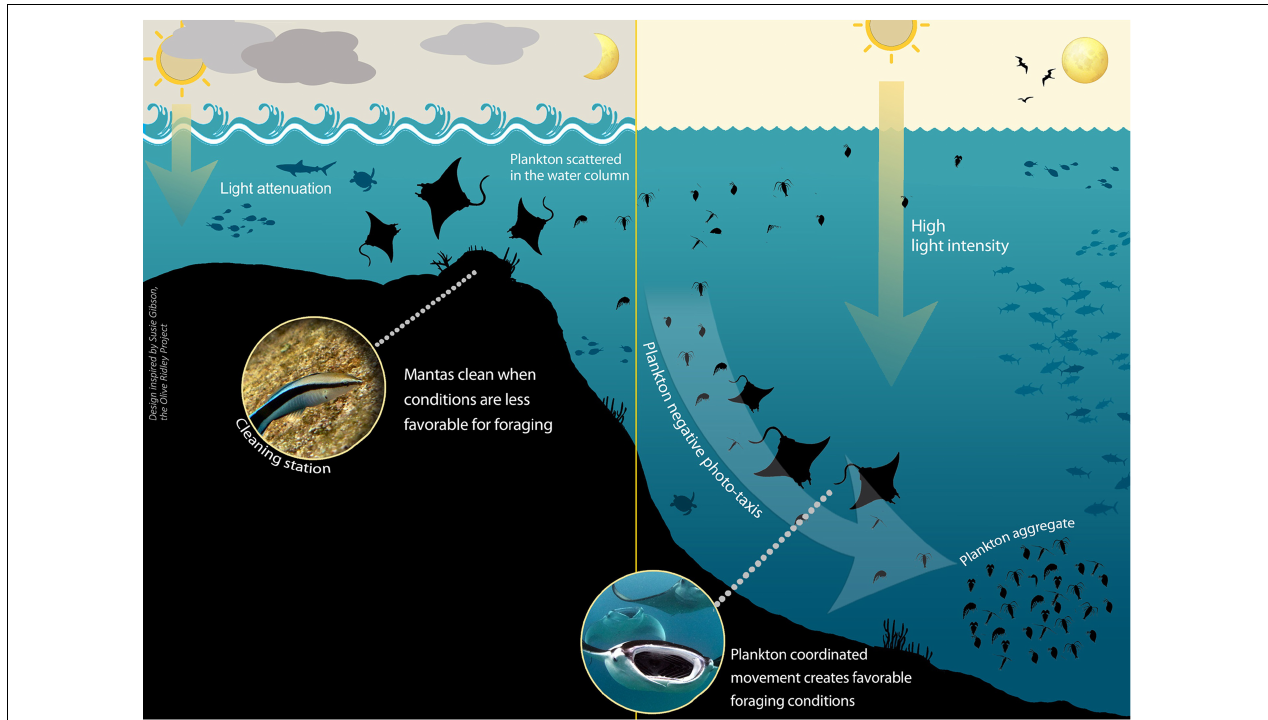
FIGURE 2 | Environmental conditions dictating manta ray behavior and location. A summary of the proposed mechanism of how Time of day (particularly the angle of the sun), Sea state, Cloud coverage, and Moon illumination affect plankton movement and distribution, and hence manta presence at the cleaning stations. At times of high light intensity plankton undergo mass coordinated movement, thus their density and concentration increase, facilitating prime foraging conditions and resulting in a decline in manta presence at the cleaning stations. Light intensity is reduced by moderate to high cloud coverage, reduced angle of the sun (affected by time of day), less illuminated moon phases, and moderate sea state. Not pictured but addressed in the study are the effects of cleaner wrasse presence and strong turbulence.